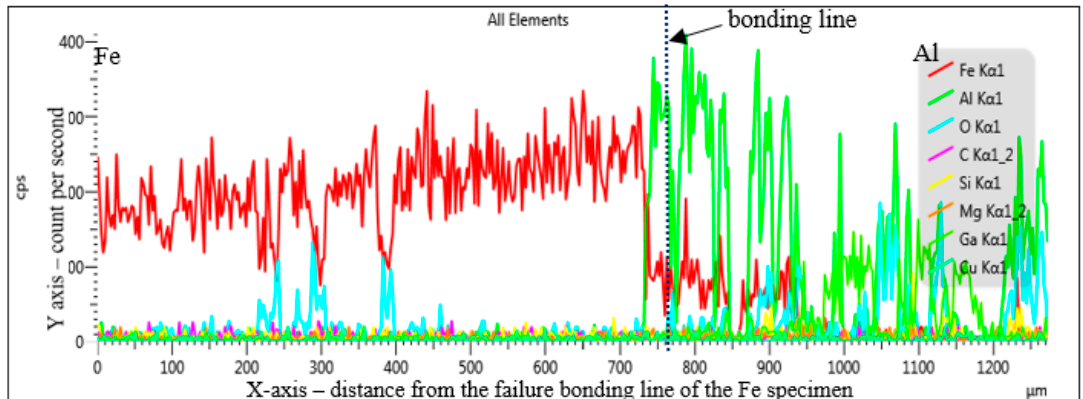
Figure 4. Linescan Analysis along the bonding line of Al–Fe Joint Cross Section .